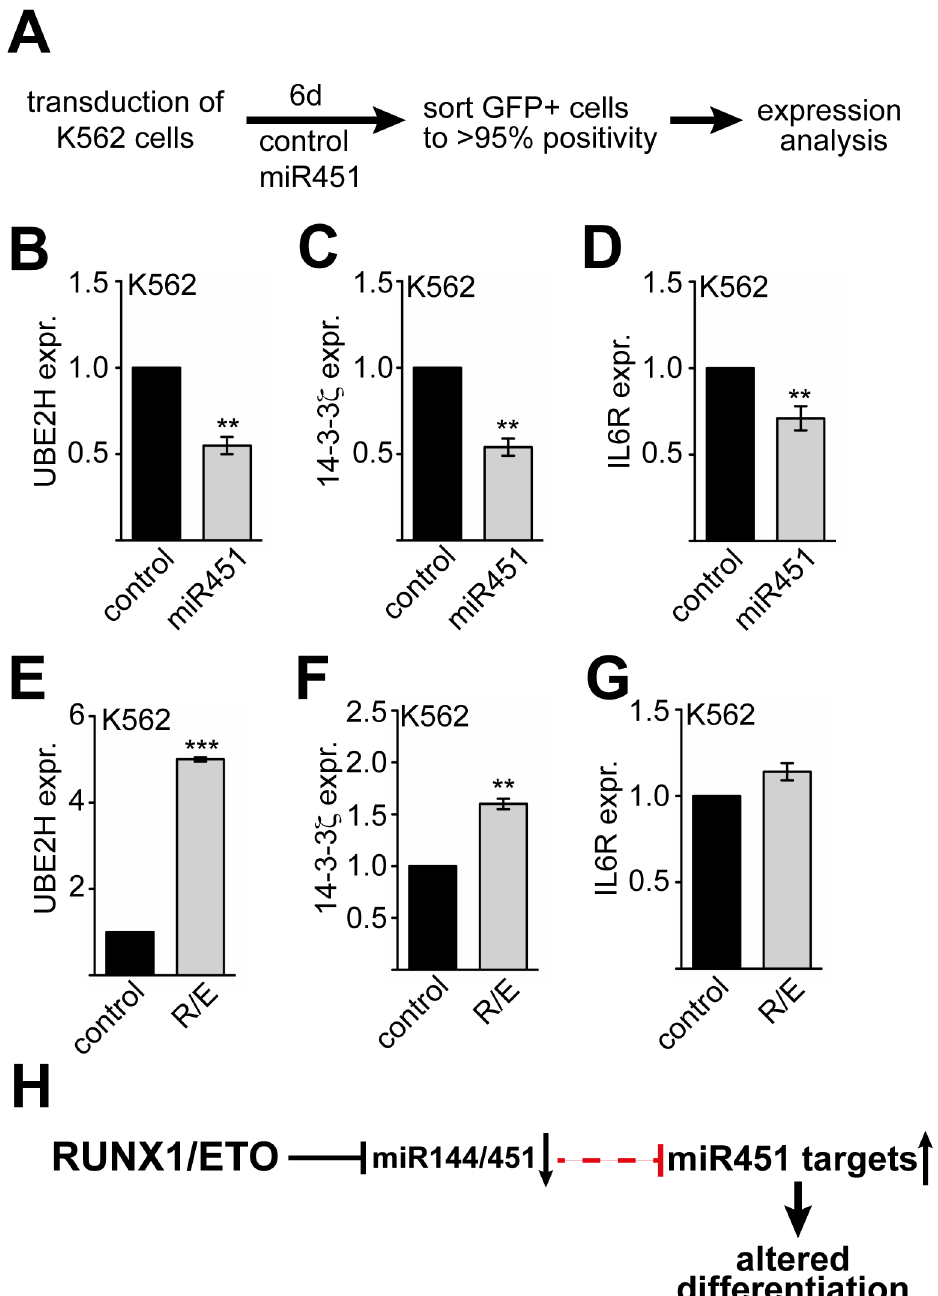
Fig 7. MiR451 and RUNX1/ETO influence miR451 target genes. (A) Schematic overview of K562 transduction with a miR451 expression vector, sorting and treatment. K562 cells were transduced, cultured for 6 days and sorted according to the GFP signal. GFP-positive cells were further analysed. (B) MiR451 over-expression in K562 cells leads to down-regulation of the miR451 target UBE2H at the mRNA level. (C) MiR451 over-expression in K562 cells leads to down-regulation of the miR451 target 14-3-3 ξ at the mRNA level. (D) MiR451 over-expression in K562 cells leads to down-regulation of the miR451 target IL6R at the mRNA level. (E) Over-expression of RUNX1/ETO increases UBE2H expression at the mRNA level. (F) Over- expression of RUNX1/ETO increases 14-3-3 ξ expression at the mRNA level. (G) Over-expression of RUNX1/ ETO has only a minor influence on IL6R mRNA expression. (B-G) Q-RT-PCR values are shown as relative expression compared to K562 cells transduced with an empty control vector and normalised to GAPDH expression. The error bars represent the standard deviation from at least four independent